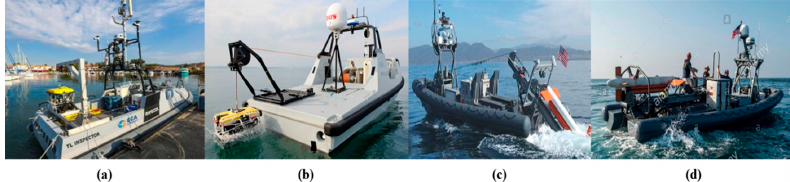
Figure 1. Combined Unmanned Ocean Platform: ( a ) Inspector USV with H300V; ( b ) Halcyon-Seaeye; ( c ) AQS-24 with Spartan; ( d ) Mine Hunting Unmanned Surface Vehicle (MHU).